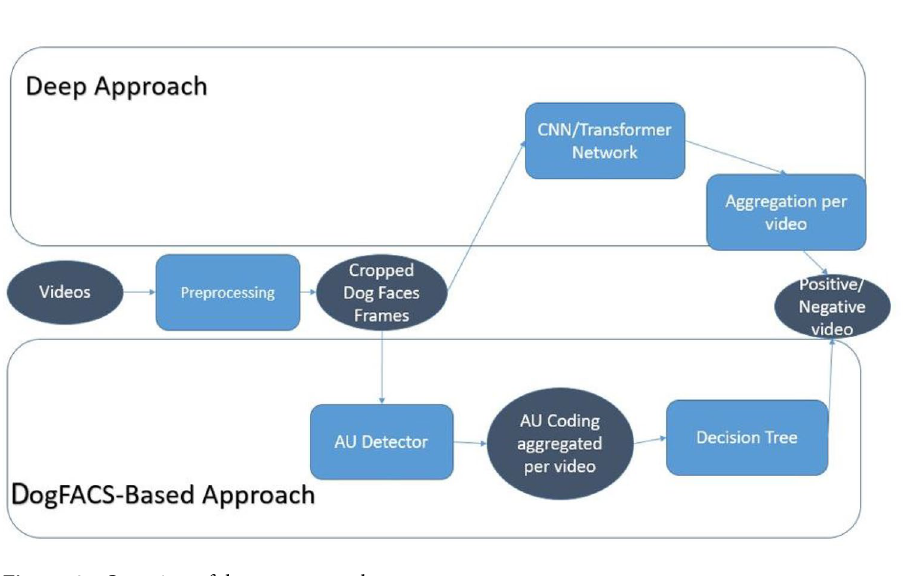
Figure. 3. Overview of the two